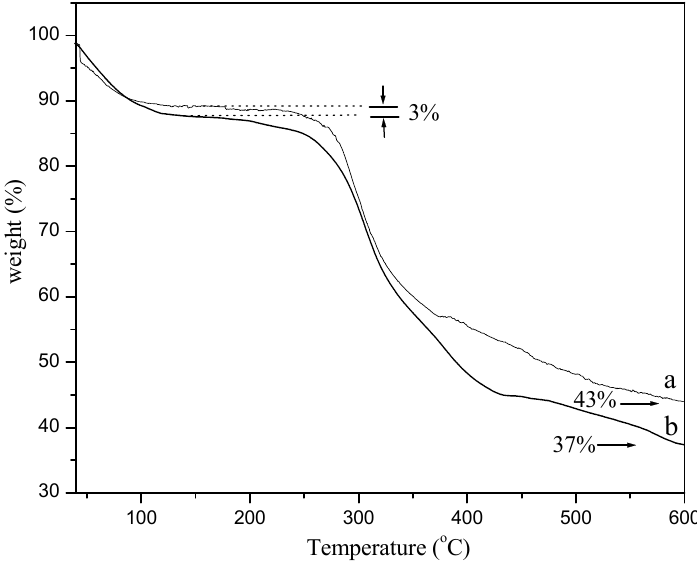
Figure 3. TGA curves of ( a ) pure silk nanofibers; and ( b ) silk/TMOS nanofibers with TMOS concentration of 5 wt %.